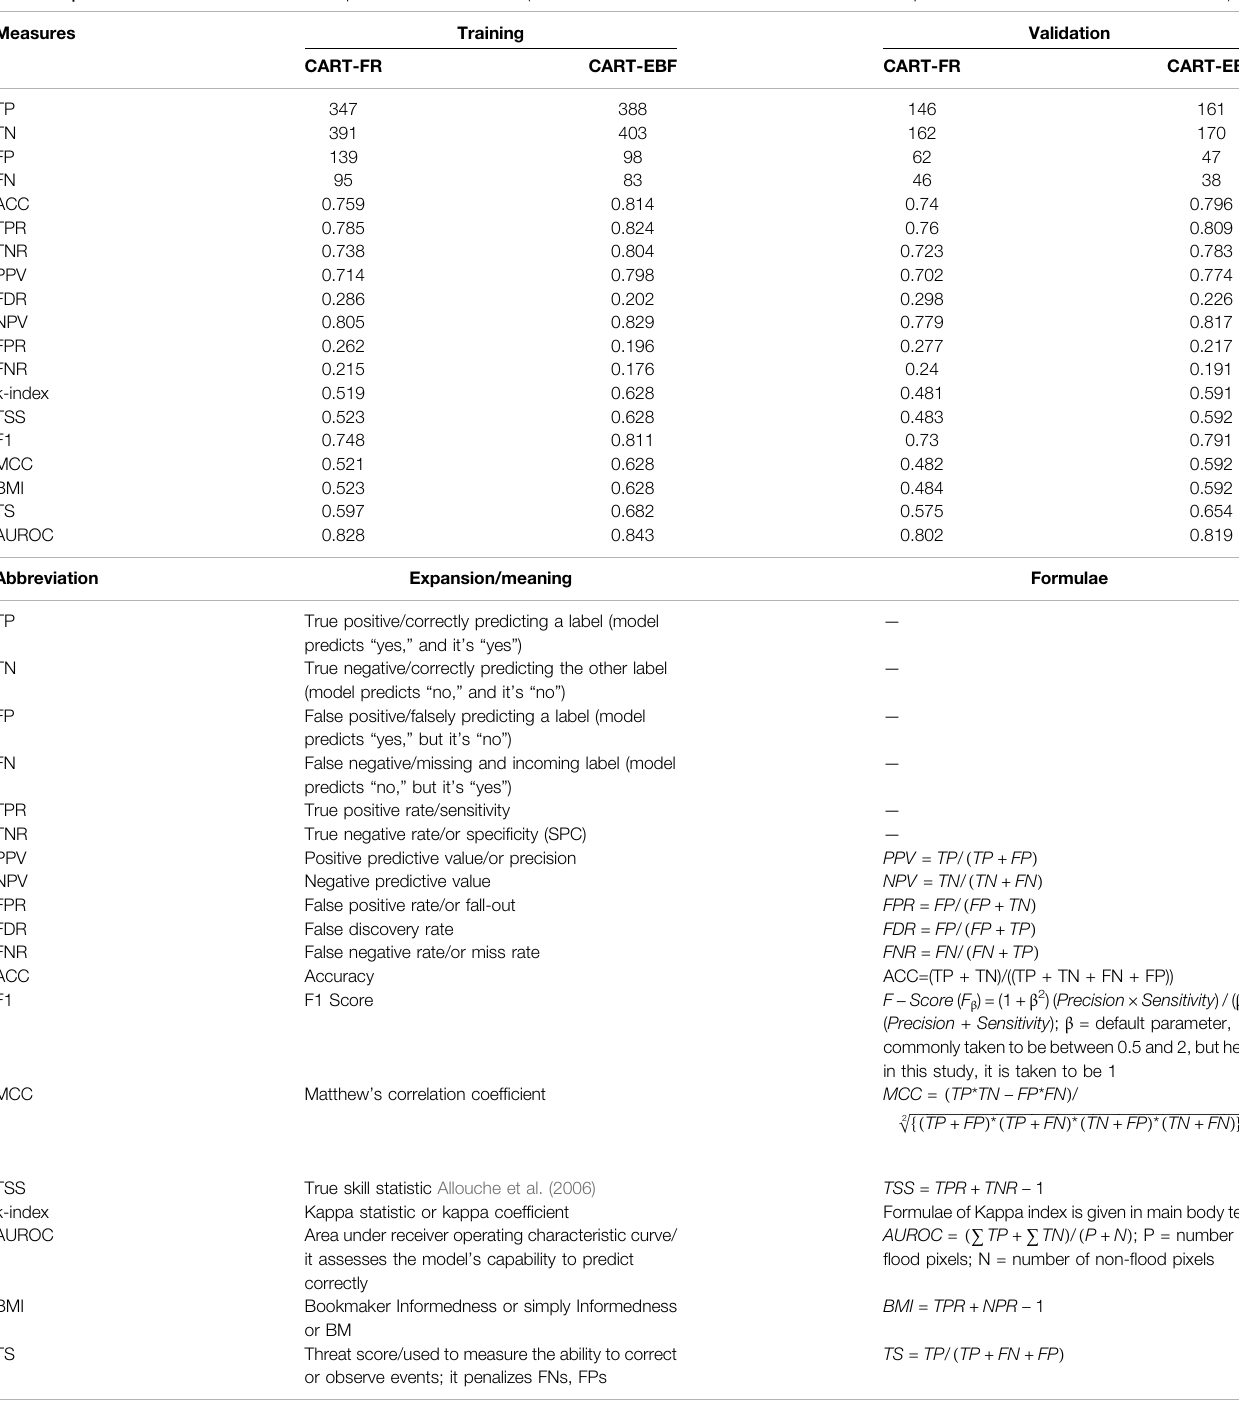
TABLE 7 | Statistical metrices used for model performance evaluation (Note: All the abbreviations used in this table are expanded and de fi ned below this table itself).